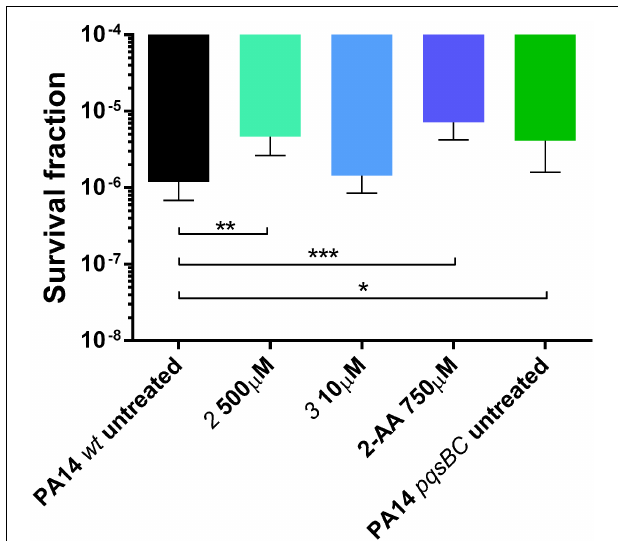
FIGURE 10 | Persister cells survival of PA14 wt with and without PqsBC inhibitors 2 and 3 , or 2-AA and PA14 pqsBC mutant after the treatment with 10 µ g/mL of meropenem for 24 h. The error bars indicate 95% Confidence Interval of the geometric mean. Statistical analysis performed with non-parametric one-way ANOVA ( α = 0.05; ∗∗∗ p < 0.003; ∗∗ p < 0.01; ∗ p <